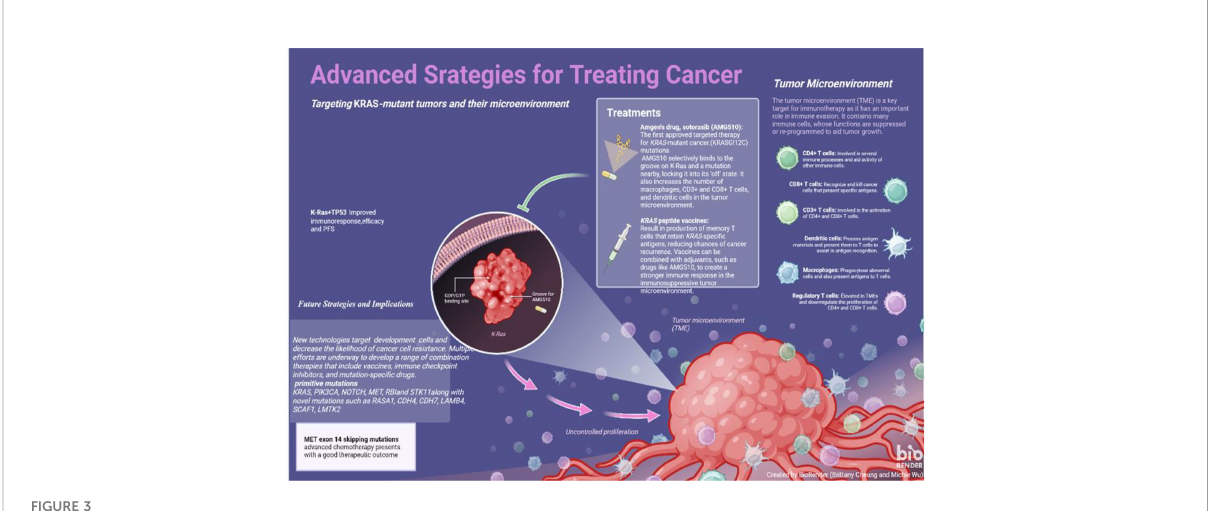
FIGURE 3 Advanced strategies for treating